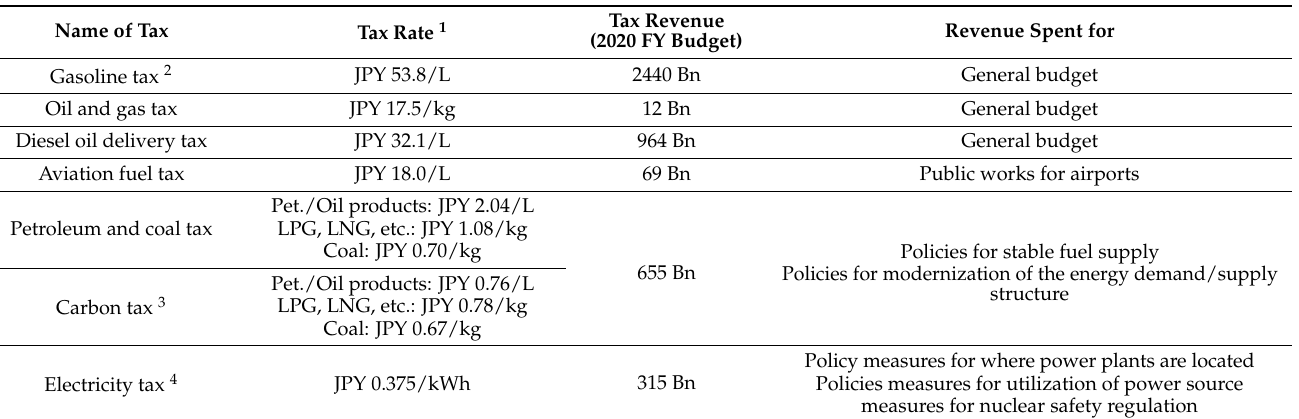
Table 1. Energy tax in Japan (modified from [31]).